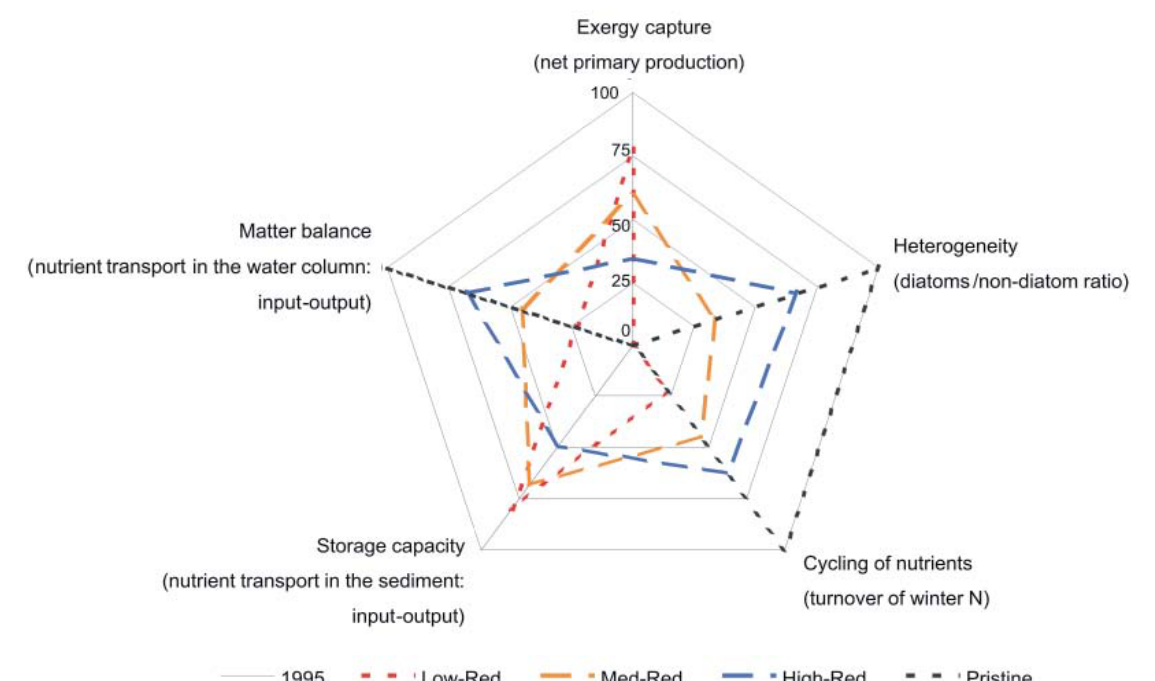
Figure 4. Integrity indicators. Normalised values for the three considered eutrophication scenarios and the two reference conditions of maximum (1995) and minimum risk (pristine). The eutrophicated state (maximum disturbance, 1995) is indica- ted by the highest primary production and extremely positive N sediment budget (N retained in the sediment). The tendency to reduce primary production as a consequence of reduced N inputs into the system is clearly seen. In the same way, (i) the tendency to increase the diatom/non-diatom ratio (i.e. to increase the trends towards a low nutrient input situation more similar to historical records of non-eutrophicated situations), (ii) to increase the cycling of winter nutrients (the system needs to re-use available nutrients, if the inputs of new nutrients is reduced), (iii) to minimise matter losses (i.e. to increase the quantity of matter retained by the system) and (iv) to retain nutrients in the sediment, are also observable. The sediments re- present a buffer for the system, being a sink for overabundant nutrients and a source in scarcity times. The sediment budget (N in the sediment) tends to decrease in pristine conditions (minimum